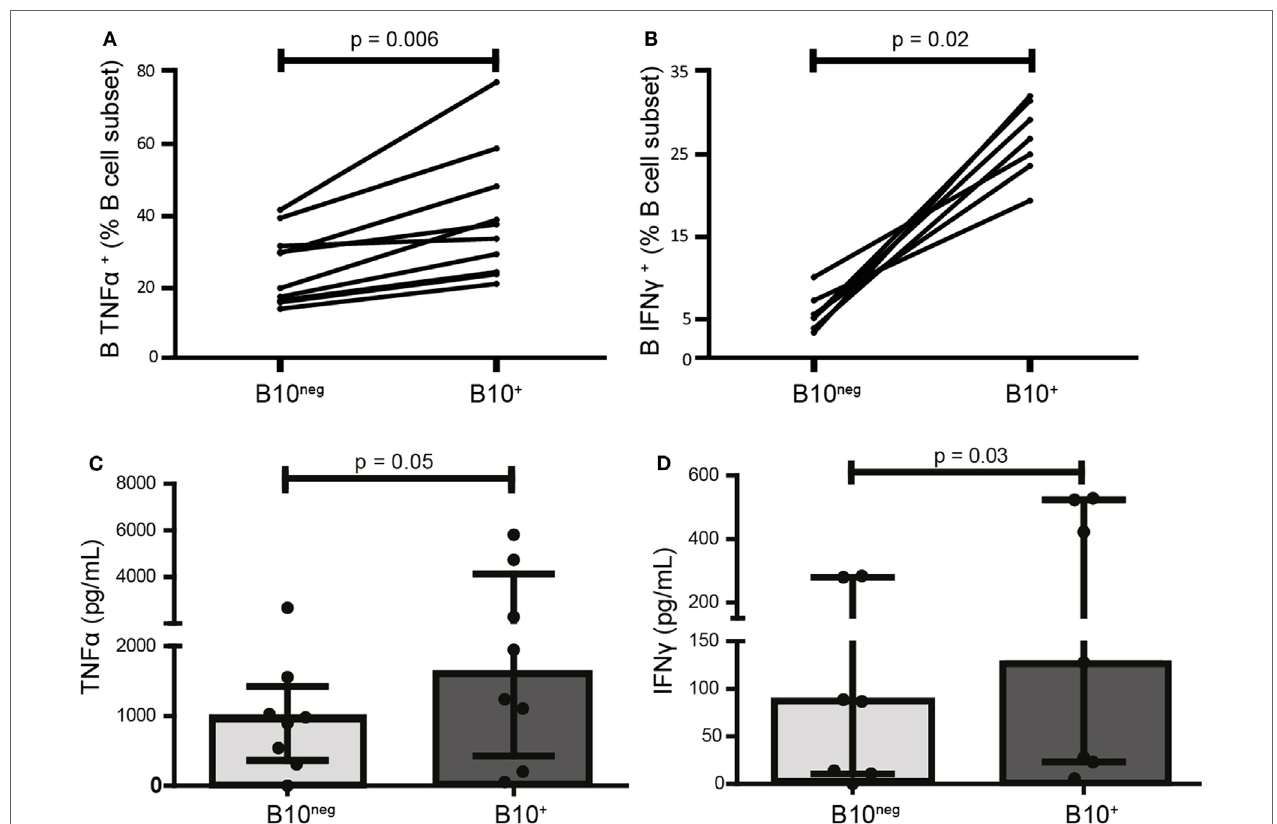
FigUre 1 | CpG-induced B10 + cells are more prone to produce pro-inflammatory cytokines than B10 neg cells. PBMCs were isolated from whole blood of healthy donors, stimulated 24 h with CpG, and stained intracellularly for tumor necrosis factor α (TNF α ) (a) IFN γ (B) , and IL-10. Cytokine production was assessed by flow cytometry in B10 + subset and B10 neg subset. In (c,D) , TNF α and IFN γ concentration in the supernatants after 24 h of culture of isolated B10 + and B10 neg were measured by ELISA. Results are shown as median ± interquartile ranges and Wilcoxon matched pairs test was used for statistical analysis. n =